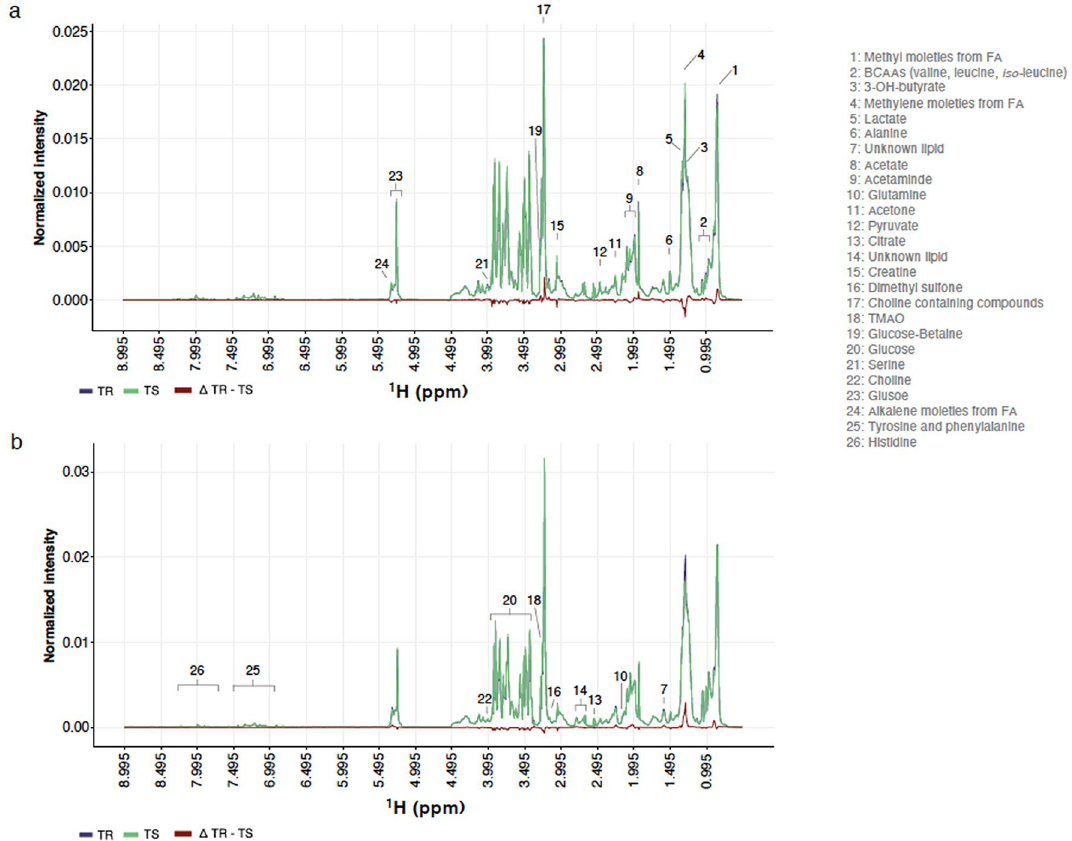
Figure 2. Representative 1 H-NMR spectra measured in resistant and susceptible ponies. Group average 1 H- NMR signal intensities are plotted against the considered chemical shifts ranging from 0.995 to 8.995 ppm and overlaid for resistant (TR; purple) and susceptible (TS; green) pony groups at day 0 (strongyle-free; panel a ) or day 132 (strongyle infected; panel b ). Differential intensity between groups is drawn in red. Associated metabolites are annotated by